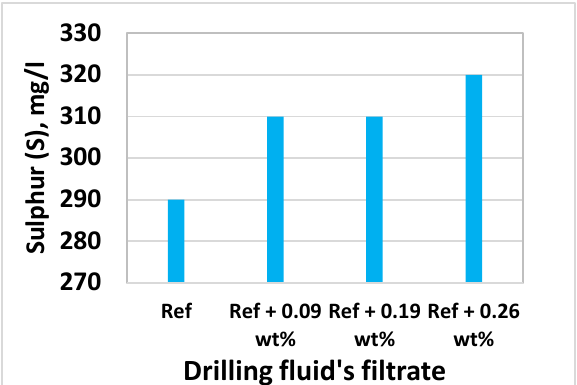
Figure 19. Mo in the filtrates of drilling fluids.